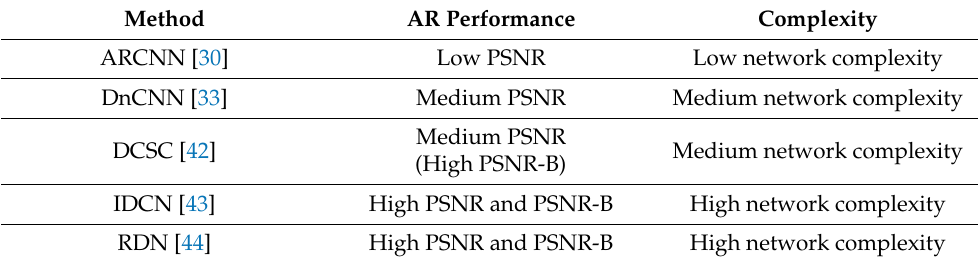
Table 1. Properties among the artifact reduction